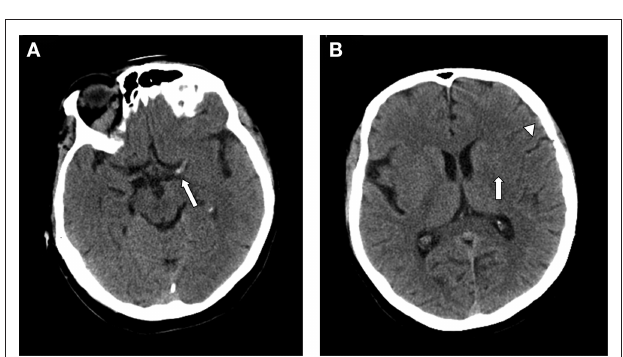
FIgure 2 | (A) Axial non-contrast CT of the head demonstrates a left hyperdense middle cerebral artery sign indicative of acute thrombus (arrow). (B) CT scan of the head without contrast showing effacement of sulci and Sylvian fissure (arrowhead) and loss of distinction of the margins of the left lenticular nucleus